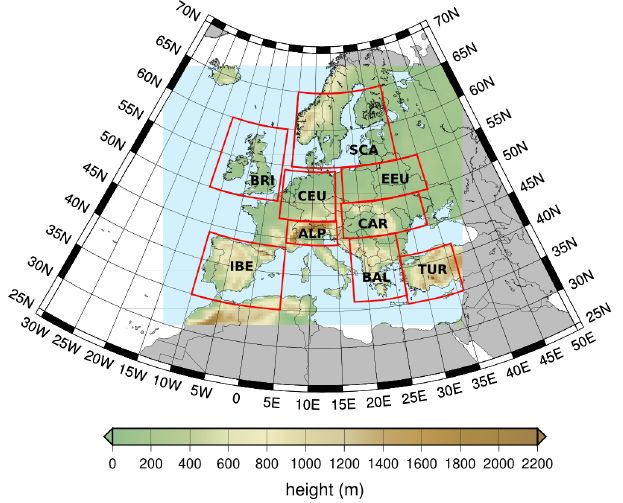
Figure 1. Topography and land mask implemented in the regional simulation, with a horizontal resolution of 45km. The rectangles show the nine subregions used for more detailed analysis. IBE – Iberian Peninsula; BRI – Britain and Ireland; CEU – central Europe; EEU – eastern Europe; SCA – Scandinavian peninsula and Baltic Sea; CAR – Carpathian region; BAL – Balkan peninsula; ALP – Alps; TUR –